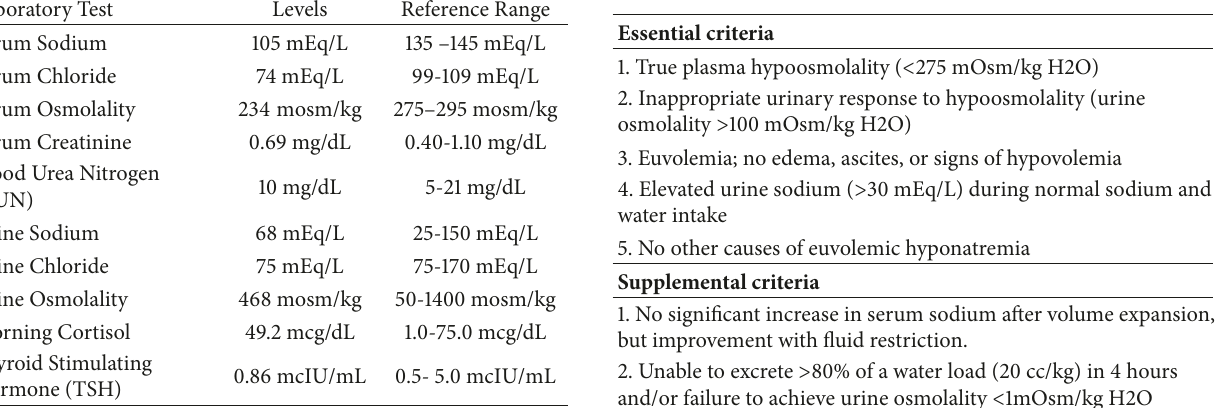
Table 1: Laboratory results at admission. Table 2: Diagnostic criteria for the syndrome of inappropriate antidiuretic hormone secretion